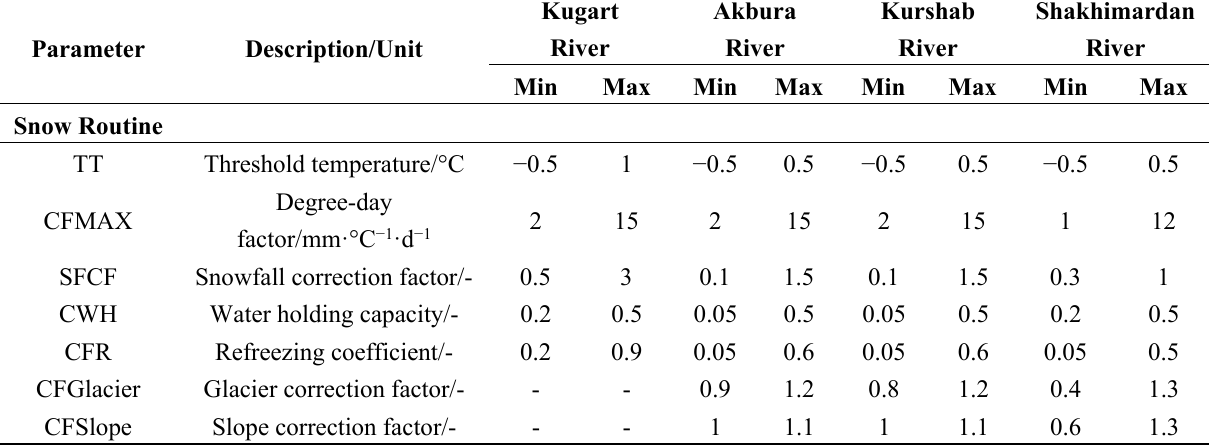
Table 5. Description of model parameters and their ranges for allocated measured temperature data and calculated precipitation of the four studied